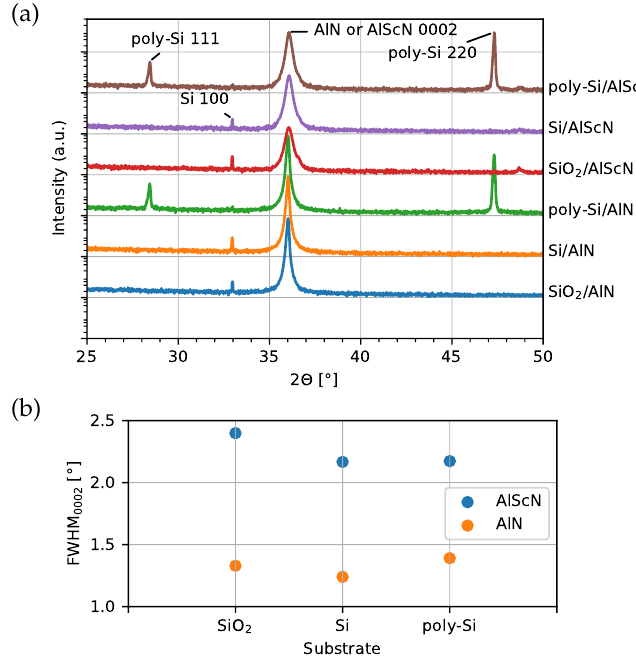
Figure 2. ( a ) θ -2 θ scans of 1µm AlN and AlScN grown directly on SiO 2 , Si and poly-Si substrates without a seed layer; ( b ) Results of rocking curve measurements of AlN and AlScN 0002 reflections. The FWHM is determined by fitting a pseudo-Voight profile using the XRD fit module (Python based open source tool for XRD peak fitting